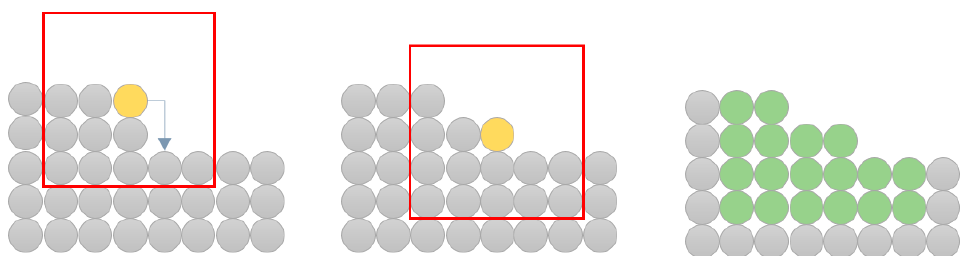
Figure 4. Procedure of choosing particles, and which interrelated events probabilities could be affected (marked as green) after applying a surface diffusion to the system (marked as yellow).